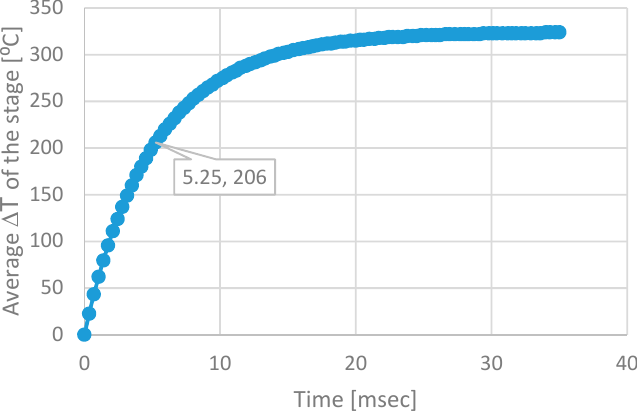
Figure 12. Transient simulation of the DUT (plate area 213.2 µ m × 213.2 µ m, arm width 6.4 µ m and